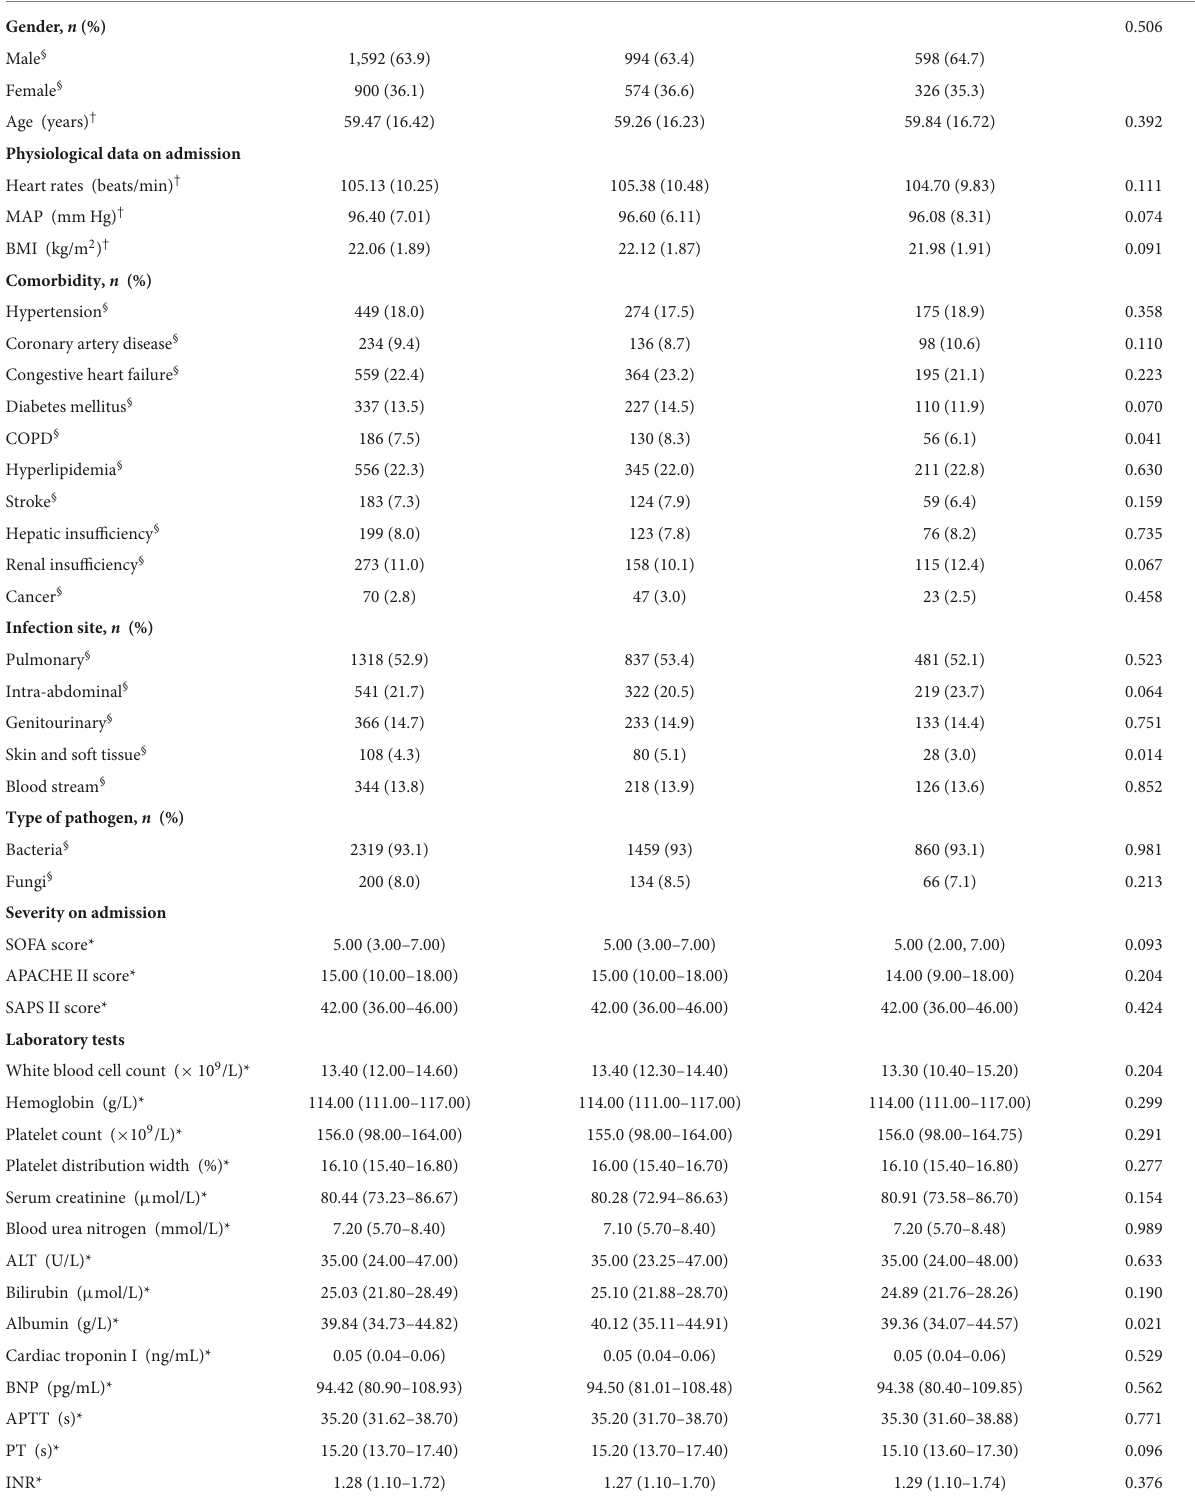
TABLE 1 Comparison of characteristics between the training and validation